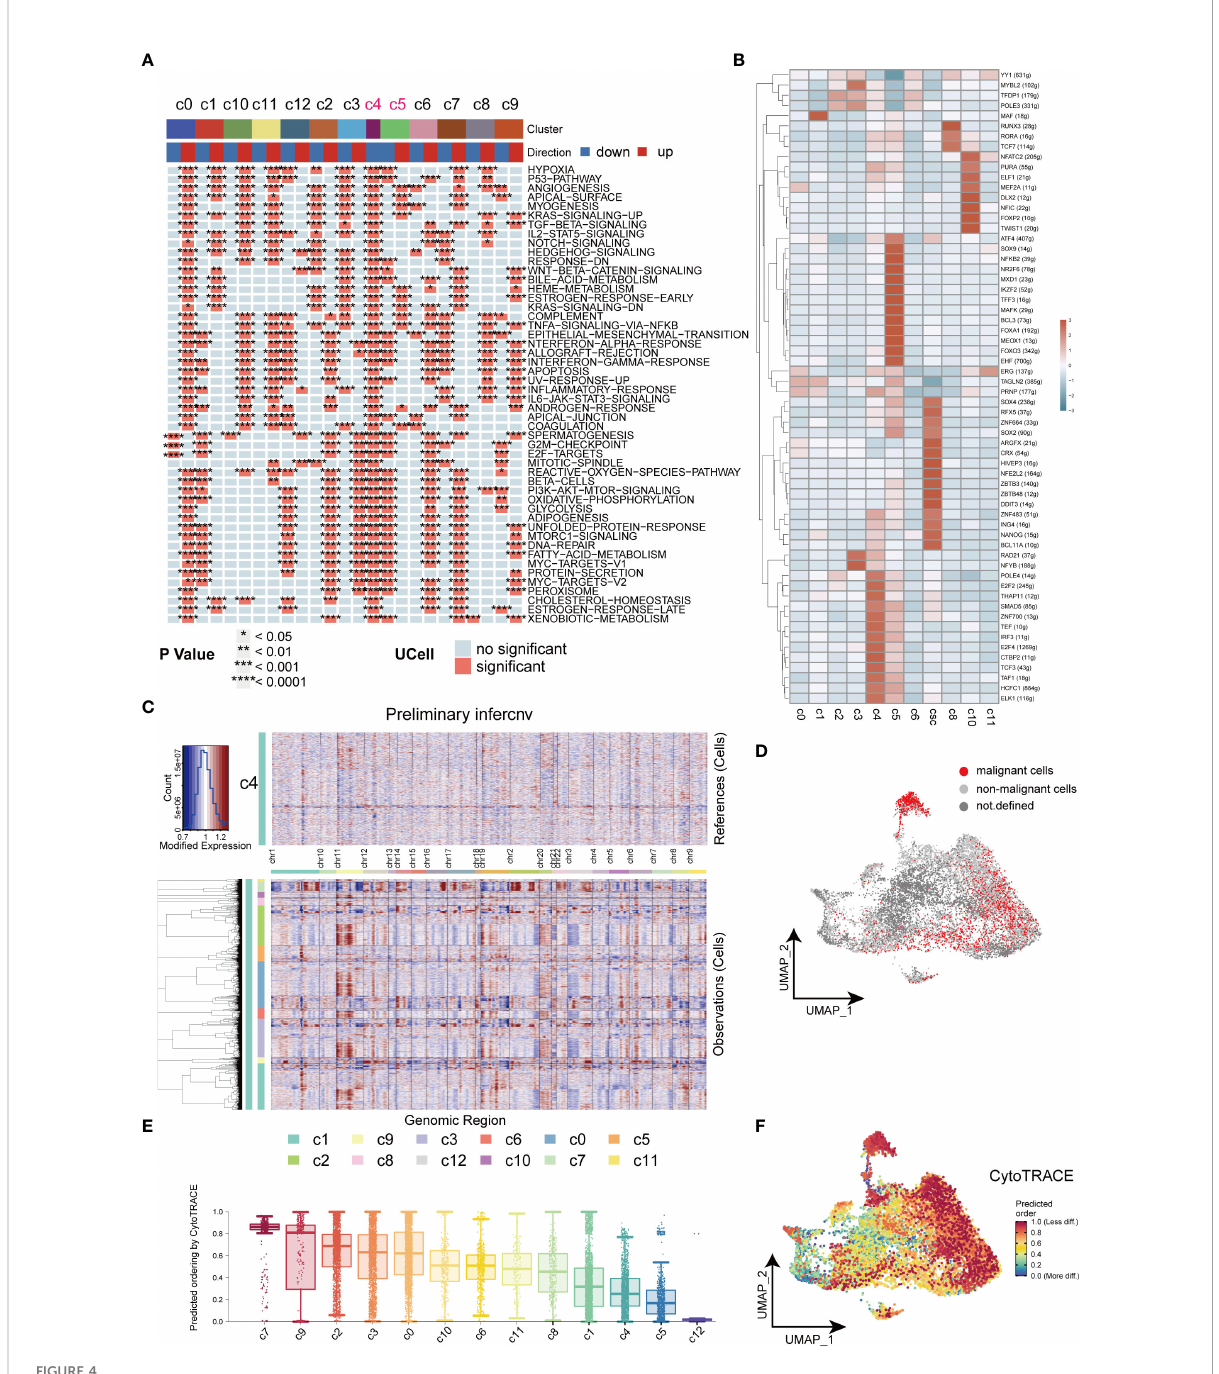
FIGURE 4 Heterogeneity in HNSCC. (A) Heatmap of cancer related signaling pathways enriched in different types of cell clusters (Hallmark gene set). (B) Heatmap of expressions of different transcription factors in cells of HNSCC. (C) Heatmap of the visualized inferCNV analysis. (D) UMAP plot of distribution of non-malignant cells in cancer cells. (E) Box plots of stemness among all the clusters in cancer cells. (F) UMAP plots of intensity of stemness in cancer cells. *P < 0.05, **P < 0.01, ***P < 0.001, ****P <